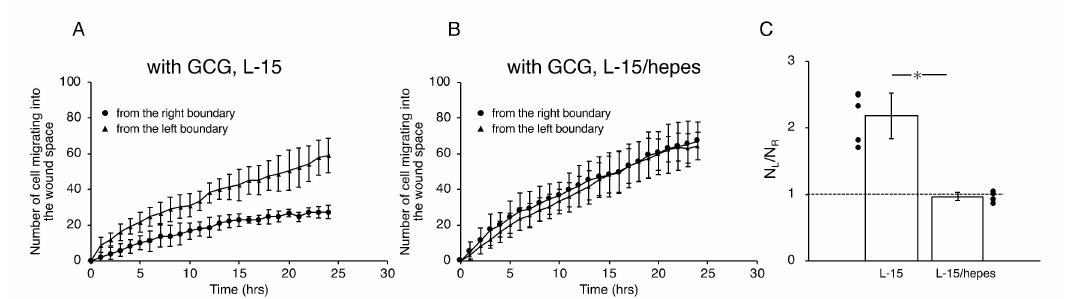
Figure 7. The number of cells that migrated into the wound space in 24 h. ( A ) In L-15 medium, N L and N R were di ff erent, consistent with what is observable in Figure 5B. ( B ) Conversely, in L-15 / hepes medium, N L and N R were the same. ( C ) The heterogeneity in cell migration ultimately disappeared in L-15 / hepes medium. Error bars represent the SD. Data were accumulated from five independent experiments. *, p < 0.05, as judged by Student’s t